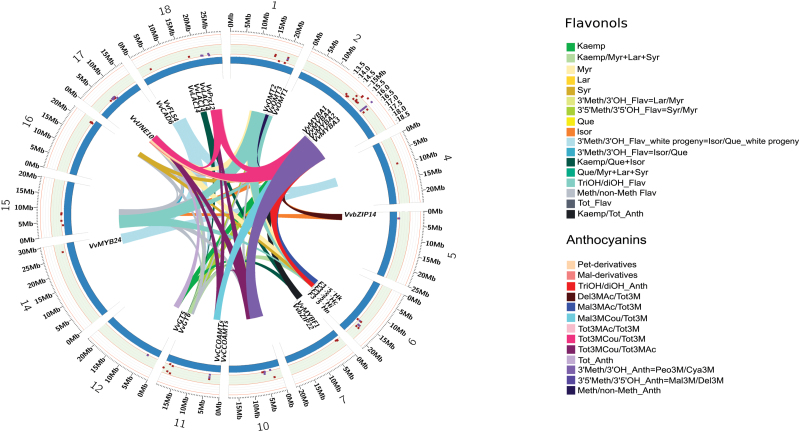
Plot of the chromosomal position of the identified QTLs for flavonol content and composition in the ‘Syrah’x‘Pinot Noir’ progeny. The regions identified by Costantini et al. (2015) controlling anthocyanin content are also presented. In both cases, only the traits regulated by at least two regions are visualized as coloured connections between chromosomes. External numbers and axes, for each blue arc, indicate the chromosomes and the physical length in megabases (Mbp), respectively. The concentric orange coloured circles represent three different levels of the explained variance for each trait (10, 50, and 90% outwards), while the red and violet squares correspond to flavonols and anthocyanins, respectively. A single colour code is associated with each trait as in the key. Gene names indicate the identified candidate genes to which particular attention was paid in the text.